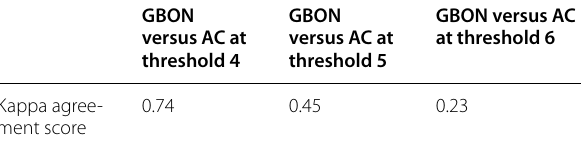
Table 3 Kappa agreement score between the GBON index and the AC index at different treatment need thresholds